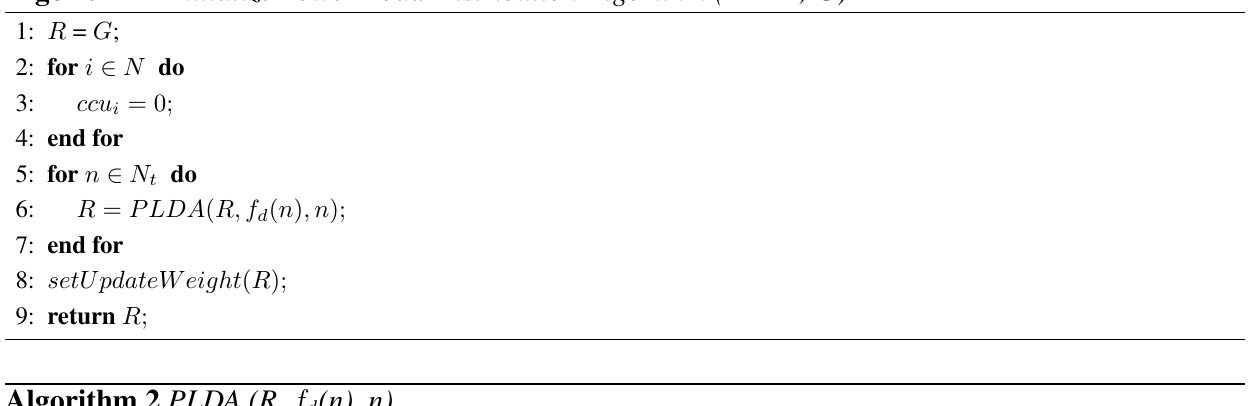
Algorithm 2 PLDA (R, f